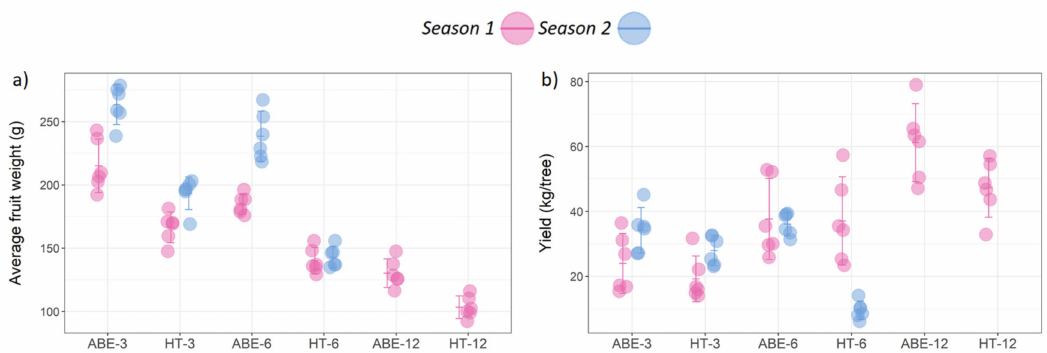
Figure 3. Effect of thinning regime and crop load on ( a ) average fruit weight, and ( b ) fruit yield per tree under different treatments across two seasons (error bars represent 95% confidence interval). ABE = artificial bud extinction; HT = hand